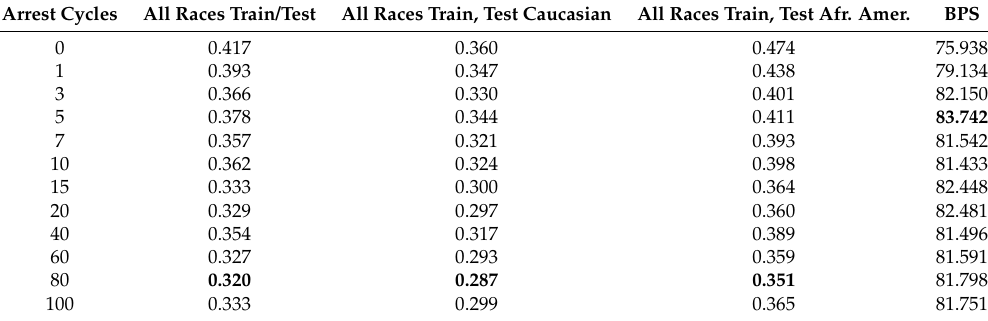
Table 3. Average false-positive rate.